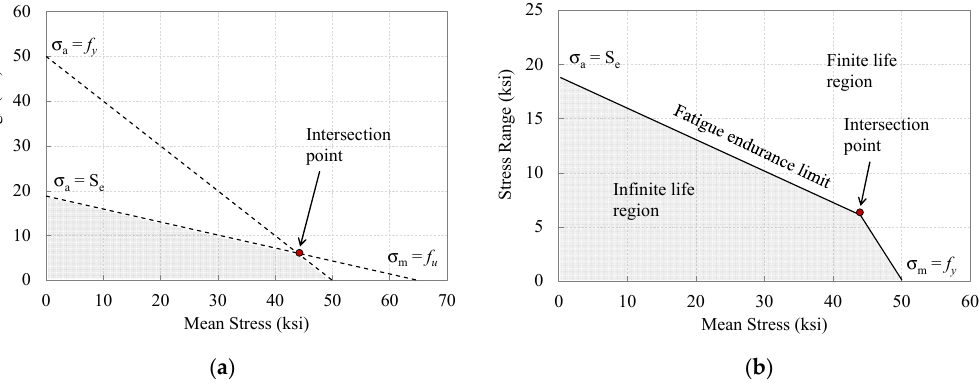
Figure 8. ( a ) Unmodified Goodman diagram and yield line; ( b ) modified Goodman life diagram.